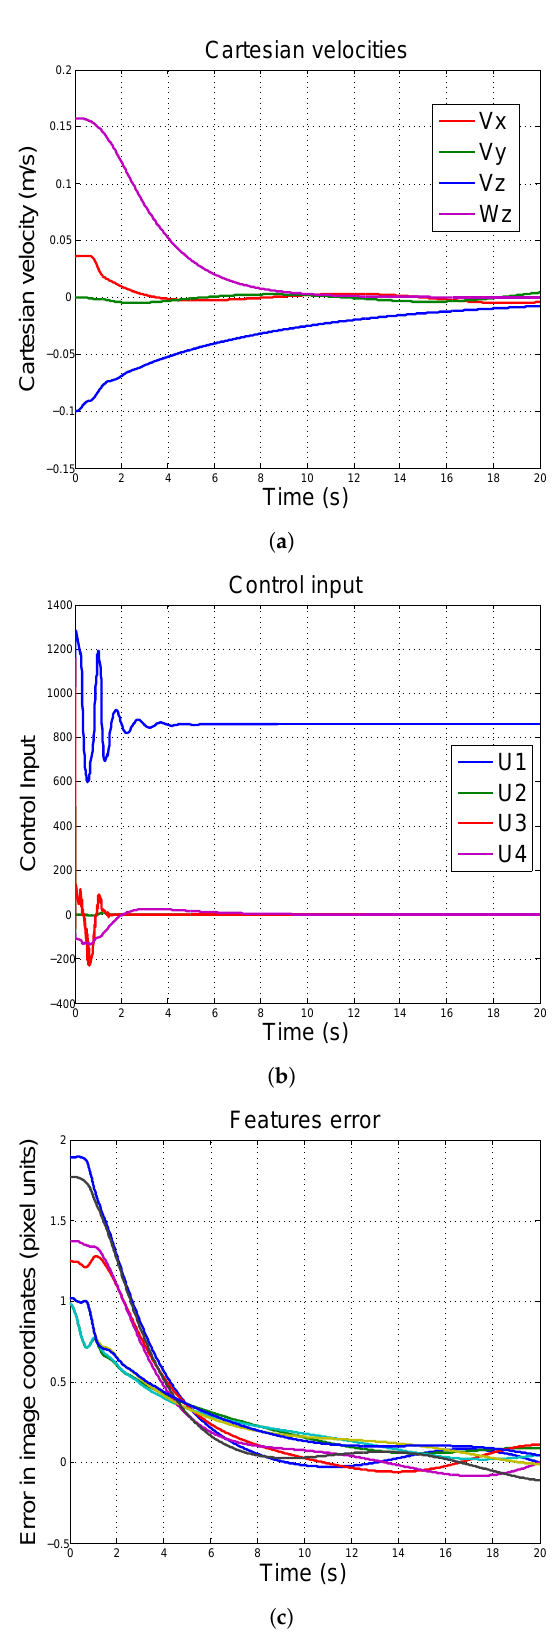
Figure 9. Simulation using ANN based PID. Moment of inertia is increased. Mass remains constant. It can be seen that the robot remains stable at desired position when I x changes. ( a ) Cartesian velocities; ( b ) control input; ( c ) features